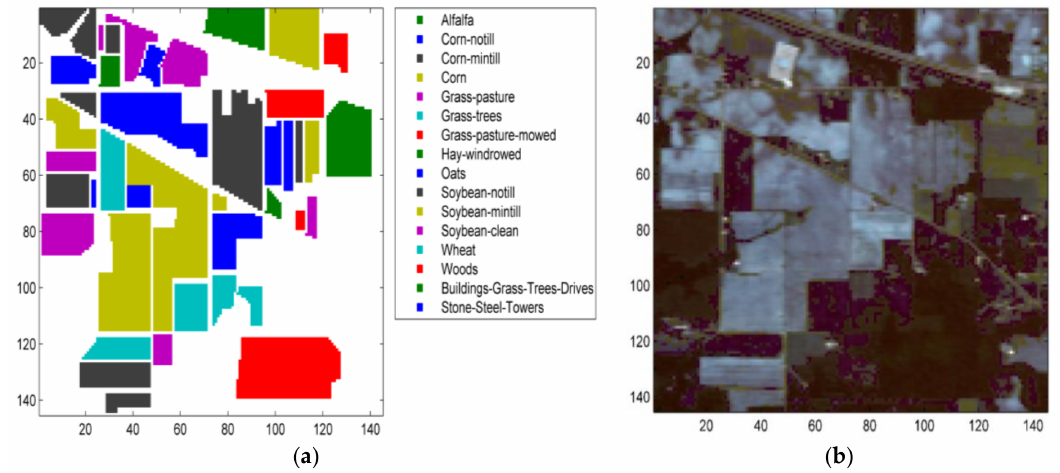
Figure 5. ( a ) Ground reference map of Indian Pines dataset. ( b ) False color composition of the Indian Pines dataset.